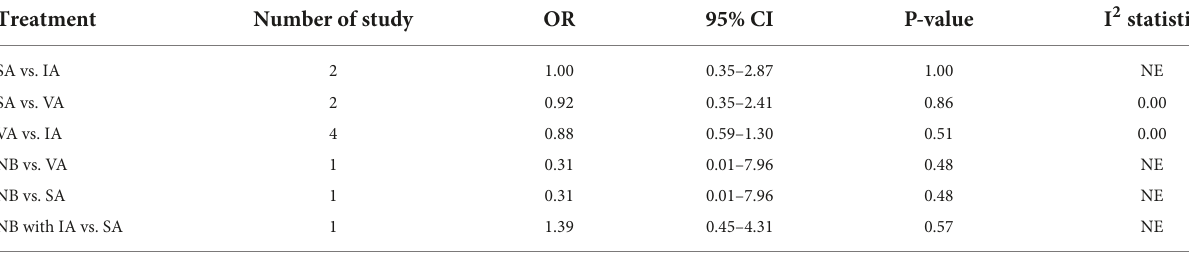
TABLE 5 The direct evidence from pairwise meta-analysis and heterogeneity of different anesthesia methods. Treatment Number of study OR 95% CI